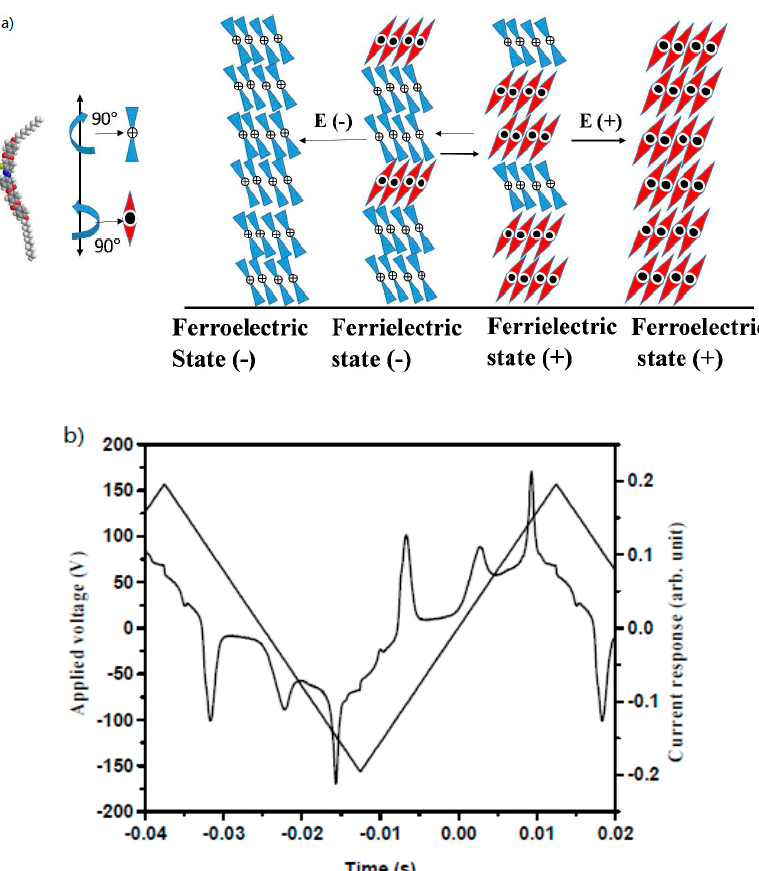
Figure 13. Layout diagram of ( a ) molecular organization of the layers and possible switching mechanism in ferrielectric state with increasing voltage as follows: Ferroelectric ( − ) → Ferrielectric ( − ) → Ferrielectric ( + ) → Ferroelectric ( + ) and ( b ) switching current response of compound 47 in the SmC phase at T = 110 °C under the high voltage of 35 V pp µm − 1. (Reproduced with permission from ref. [121], copyright American Chemical Society 2018, https://doi.org/10.1021/acs.jpcb.7b11733).